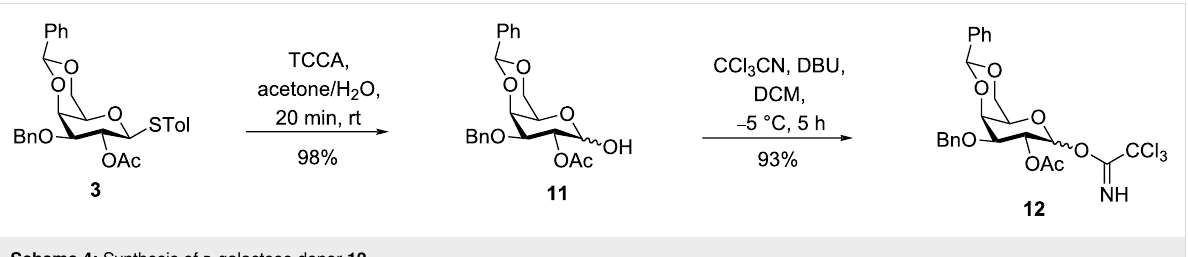
attempted the one-pot synthesis of the trisaccharide derivative